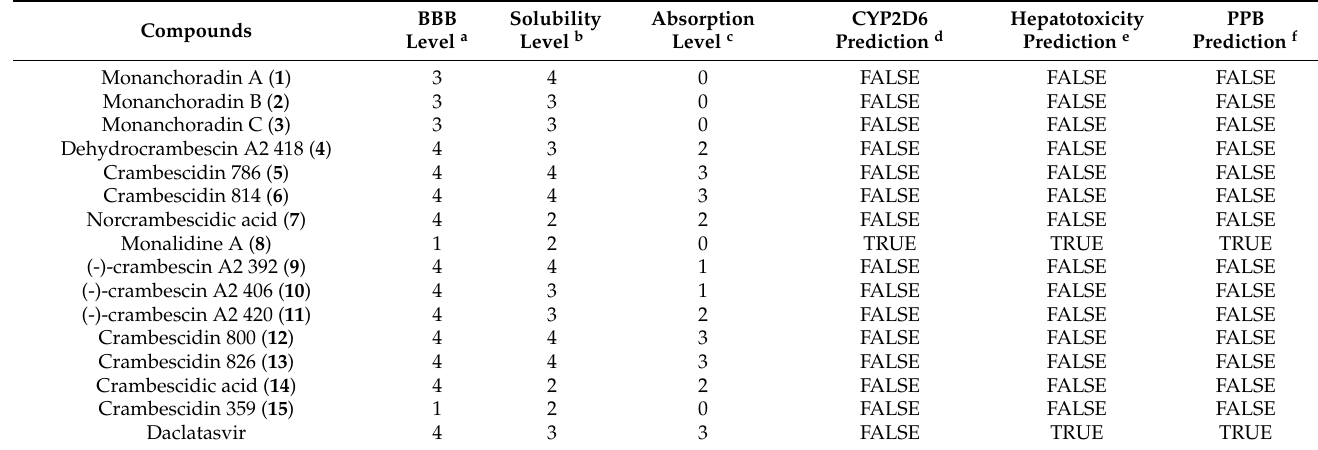
Table 2. Predicted ADMET for 15 guanidine alkaloids and reference drug, Daclatasvir. Compounds